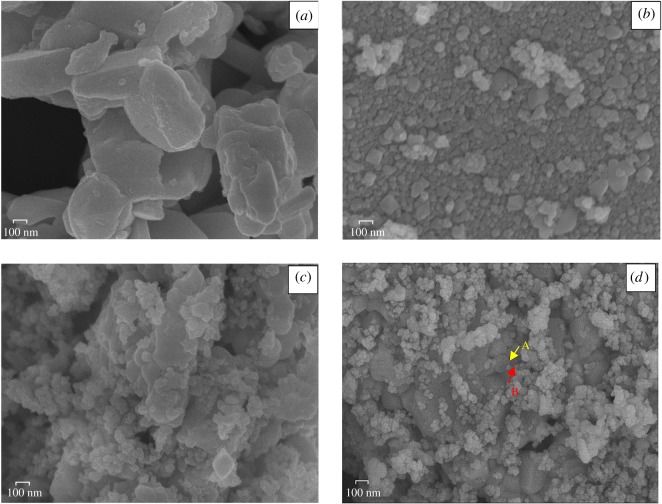
SEM micrographs of (a) BaF2, (b) TiO2 and (c,d) 0.75-BaF2–TiO2.